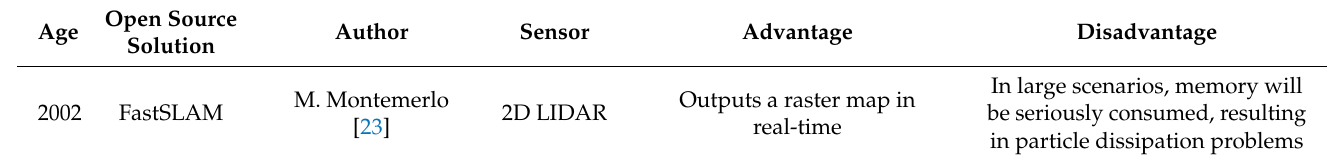
Table 3. Common algorithms in LIDAR